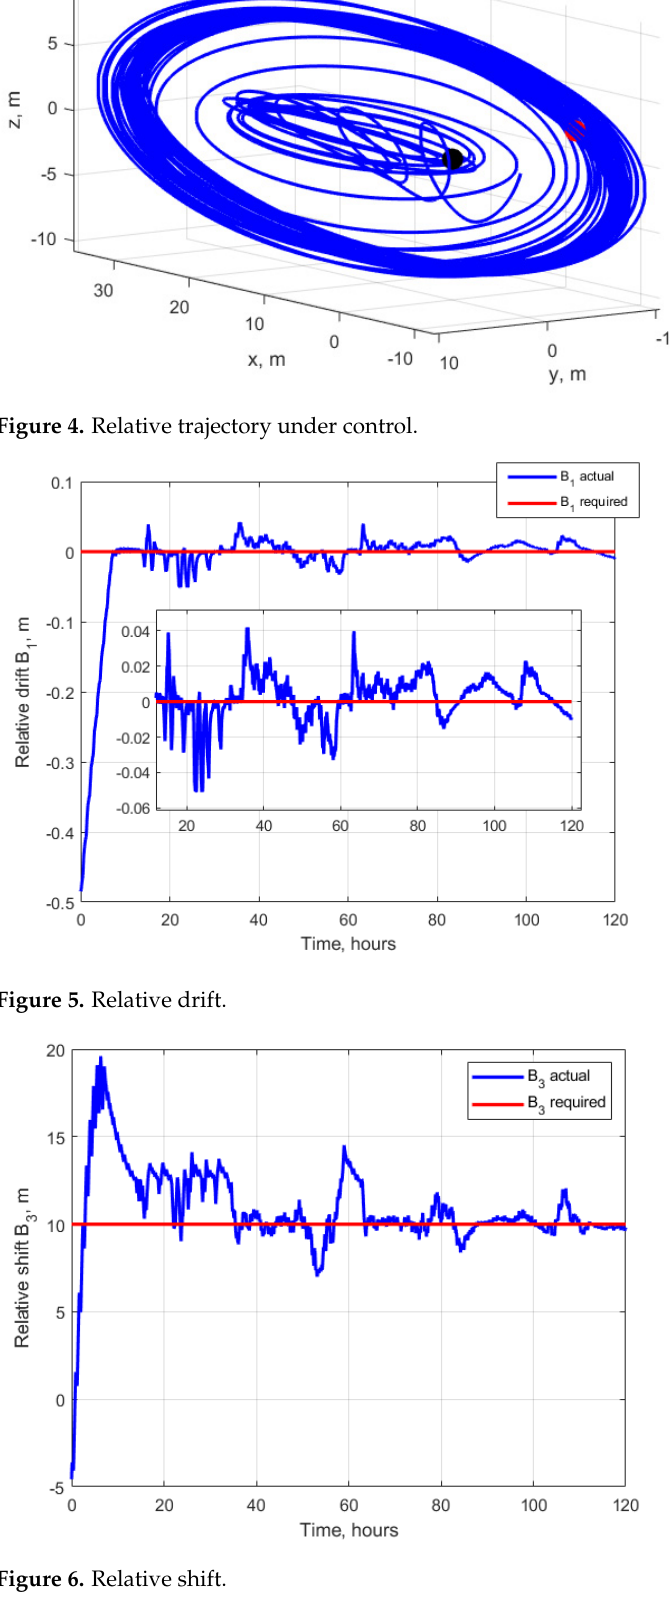
Figure 7. In-plane amplitude.